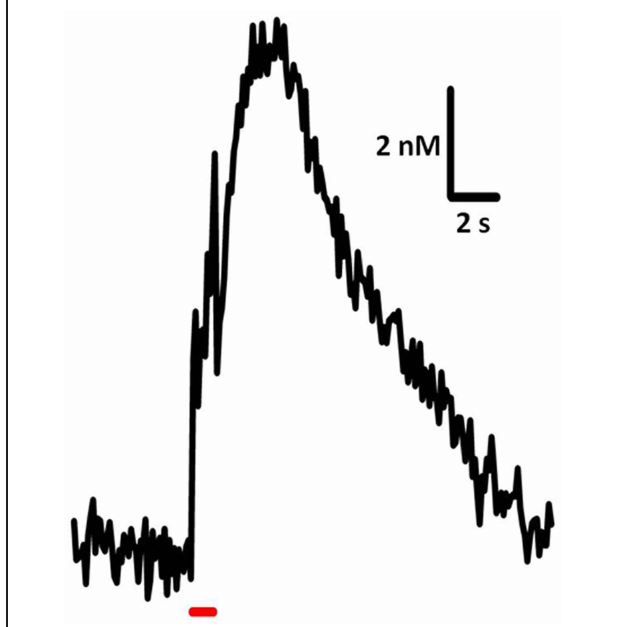
FIGURE 4 | Sample trace of in vivo serotonin release and uptake. Release was elicited using 60 pulses, 60Hz, 325 µ A stimulation of the DRN and recorded in mouse SNr. Average of signals from 7